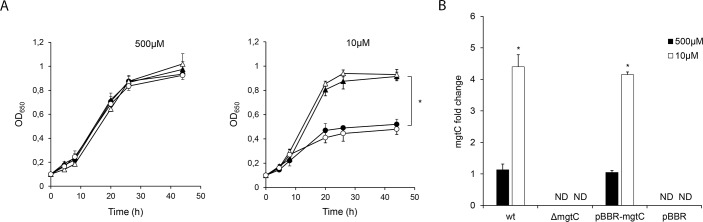
MgtC is required for growth under low magnesium availability.(A) Time course of wild type B. pertussis (wt, filled triangles), B. pertussis mgtC deficient mutant (ΔmgtC, filled circles), B. pertussis mgtC deficient mutant carrying the pBBR1MCS vector (pBBR, open circles), and B. pertussis mgtC deficient mutant carrying a pBBR1MCS derivative that encodes mgtC (pBBR-mgtC, open triangles) growth in SS medium containing 500 μM (SS) or 10 μM (SS-Mg) of MgCl2. The means ± SD of duplicates of one representative experiment out of two performed are given. The maximum OD650 of the wt and pBBR-mgtC strains grown under Mg2+-depleted conditions were significantly different from the maximum OD650 of the ΔmgtC and pBBR strains grown under Mg2+-depleted conditions. Statistical significance analysis was performed using one-way ANOVA (*P<0.05). (B) The expression level of mgtC of the wt, ΔmgtC, pBBR and pBBR-mgtC strains growing in SS or SS-Mg was measured by RT-qPCR. The recA gene was used as a housekeeping gene for normalization. The relative expression level of each gene tested was calculated by the 2-ΔΔCt method. The means ± SD of duplicates of one representative experiment out of two performed are given. The level of expression of mgtC in wild type B. pertussis growing in SS-Mg medium was significantly different from the level of expression of mgtC in wild type B. pertussis growing in SS medium. Statistical significance analysis was performed using Student's t-test (*P<0.05). The level of expression of mgtC in B. pertussis pBBR-mgtC growing in SS-Mg medium was significantly different from the level of expression of mgtC in B. pertussis pBBR-mgtC growing in SS medium. Statistical significance analysis was performed using Student's t-test (*P<0.05). ND: not detected.